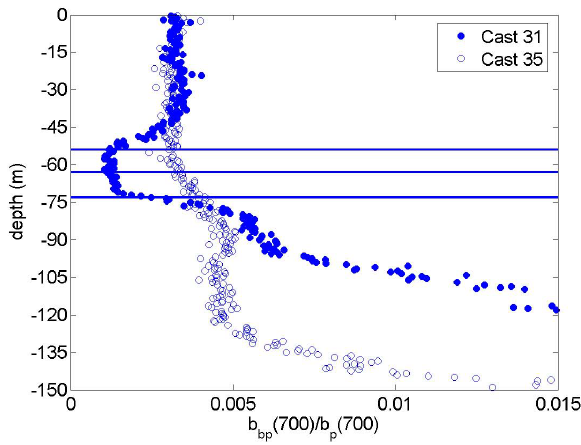
Fig. 10. Vertical profiles of ˜ b bp for Cast 31 and Cast 35.